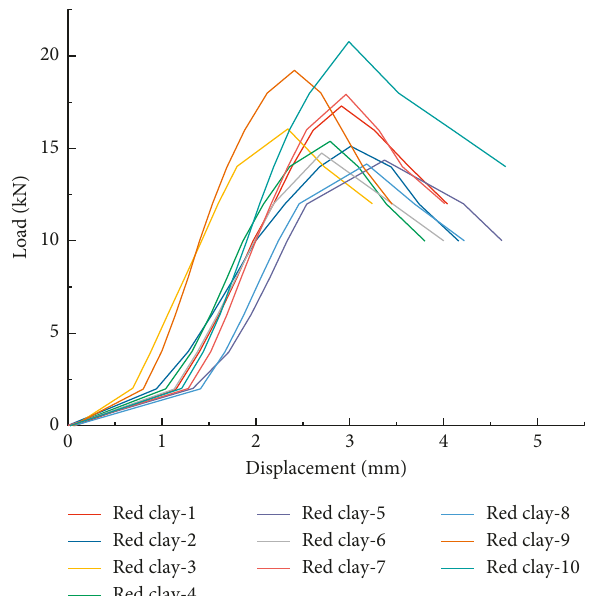
Figure 9: Load-displacement curve of clay.